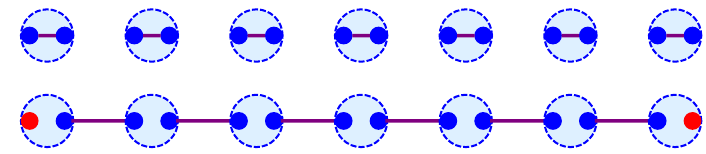
Figure 22: Top panel: Ground state of H The small blue circles are the bounded Majorana fermions and the small red circles the free